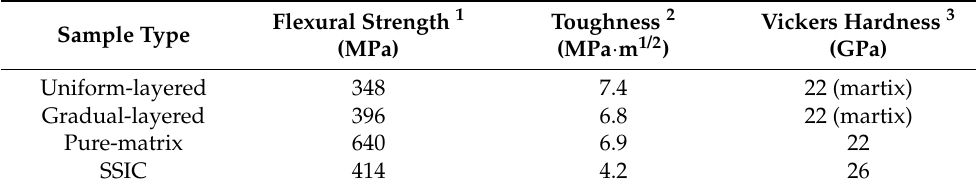
Table 2. Mechanical performance of the samples.